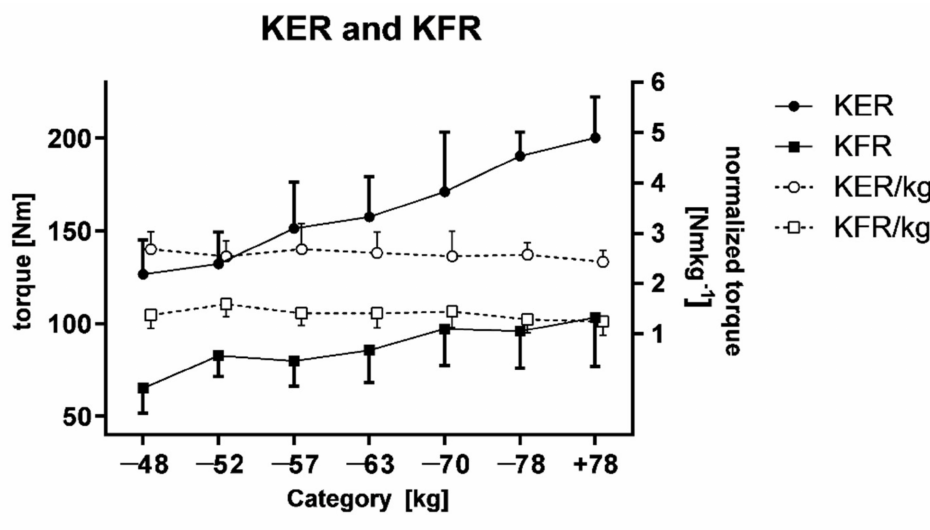
Figure 1. Mean torque and normalized torque values of extensors and flexors of the right knee. Table 2. Differences between weight categories of female judokas in peak muscle torques of the knee joint extensors and